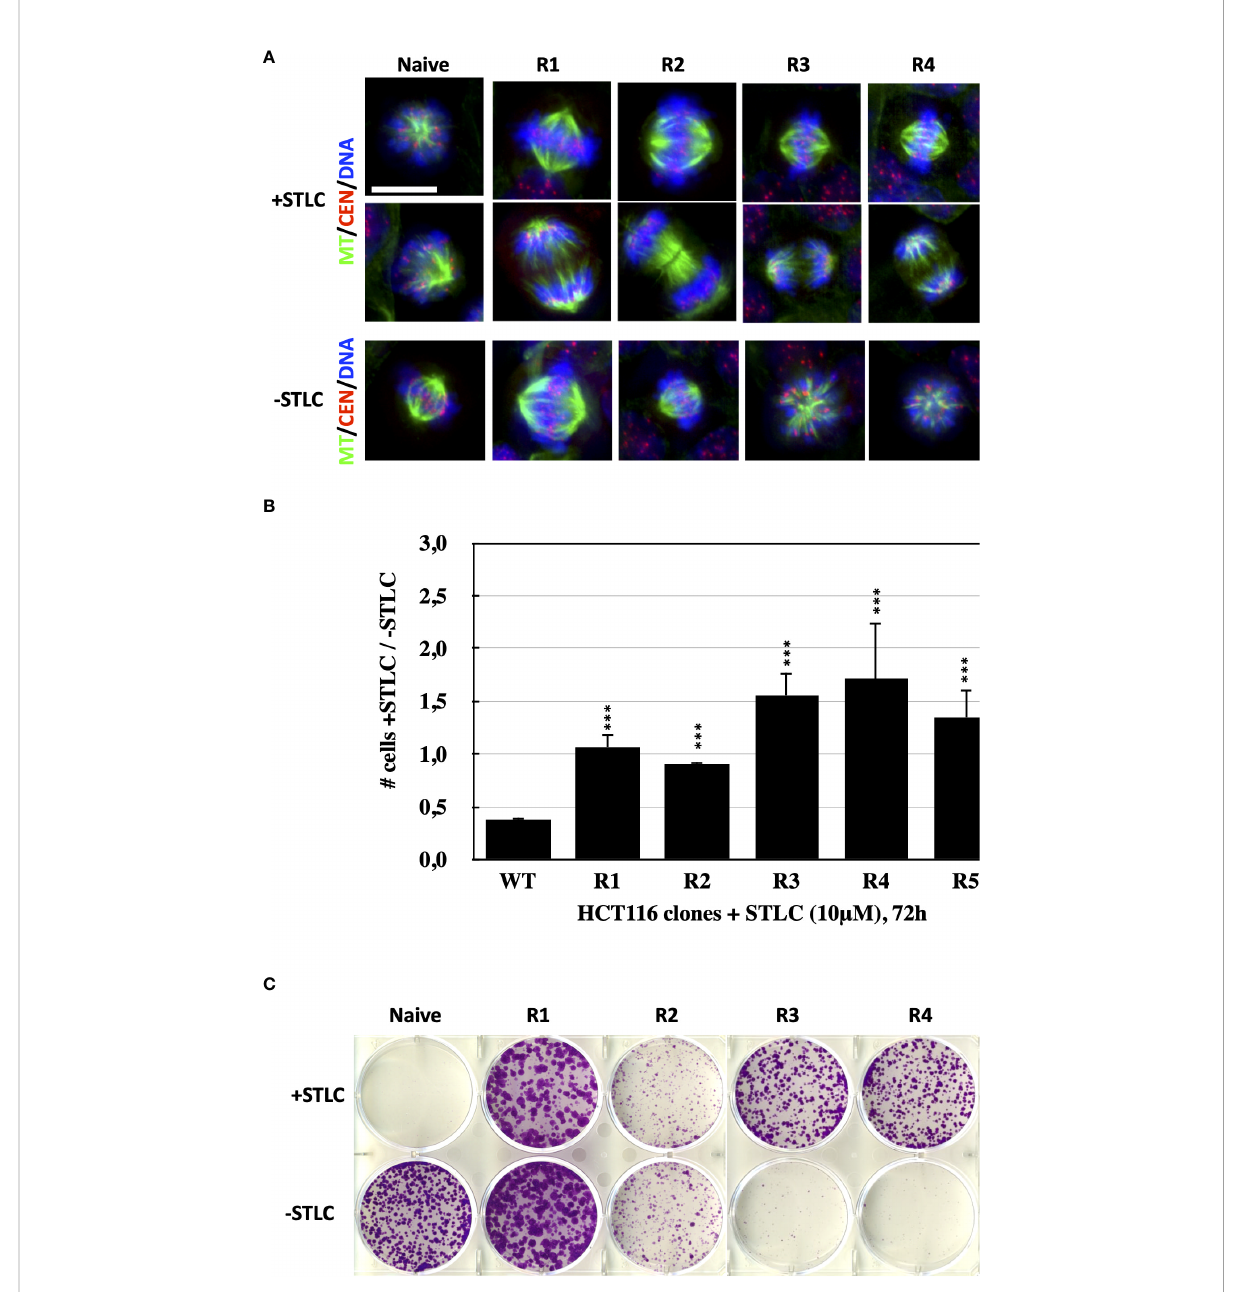
FIGURE 1 Bipolar spindle formation and proliferation of STLC-resistant cancer cells in the presence of STLC. (A) Immuno fl uorescence microscopy images of mitotic cells from naive and selected STLC resistant cells in the presence STLC 10 m M (upper two rows) and in the absence of STLC (lower row of images). Spindle microtubules were detected with an anti-tubulin antibody (green); centromeres with an auto-immune antibody (red) and chromatin with DAPI (blue). In contrast to the unselected naive cells, all resistant clones appeared to have normal bipolar spindles and were capable of proceeding to anaphase. STLC resistant clones R3, R4 and R5 in the absence of STLC had monopolar spindles. (B) Proliferations assays with the selected clones in the presence and in the absence of STLC. Ratio of the number of cells in the presence of STLC divided by the number of cells in the absence of inhibitor for unselected HCT116 cells and cells from the STLC resistant clones R1, R2, R3, R4 and R5, after 72h. Asterisks indicate signi fi cance values; *** p < 0,0001. (C) Crystal violet-stained colonies of parental HCT116 cells and drug-resistant lines (resistant clones R1, R2, R3, R4 and R5) after 14 days of exposure to STLC (upper panel) and following wash-out of the STLC (lower